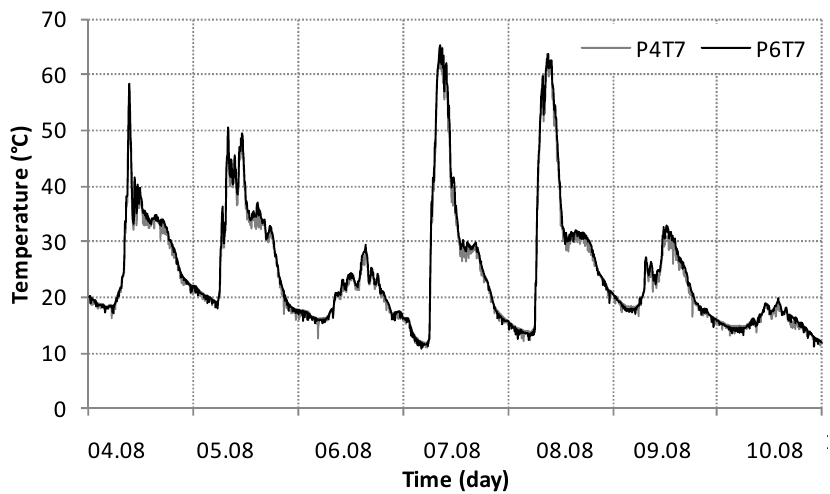
Figure 5. Verification of the external boundary condition.